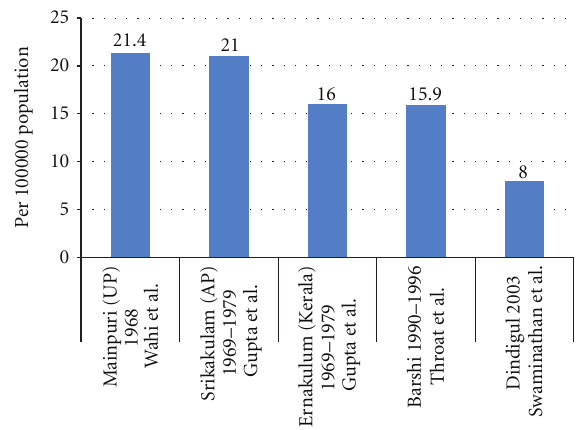
Figure 4: Age standardized incidence rates per 100,000 population comparison—rural males